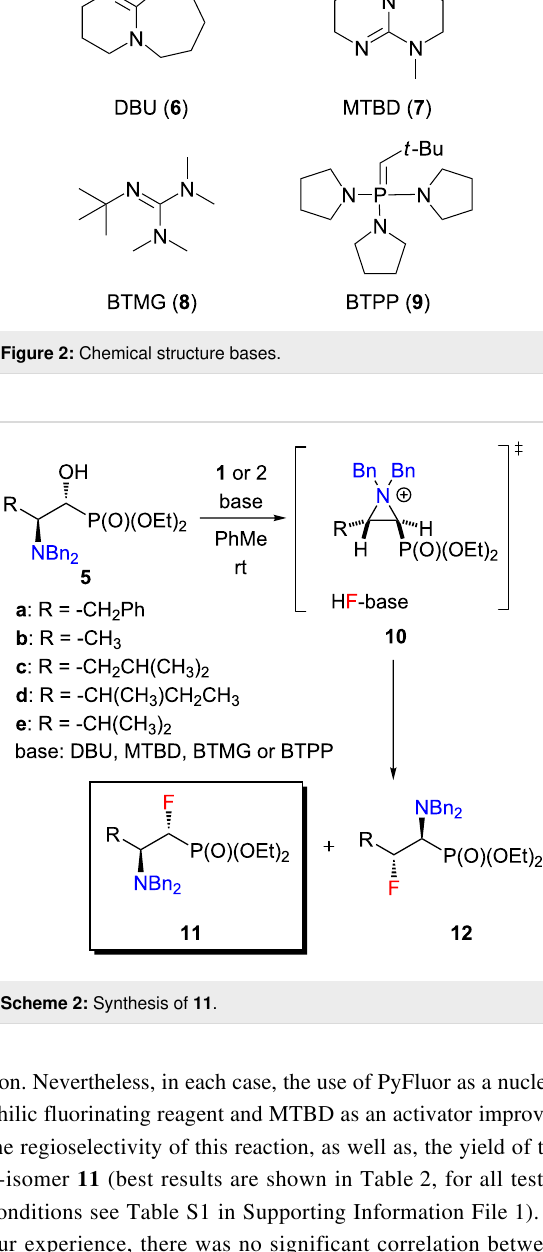
Table 2: Optimization of reaction